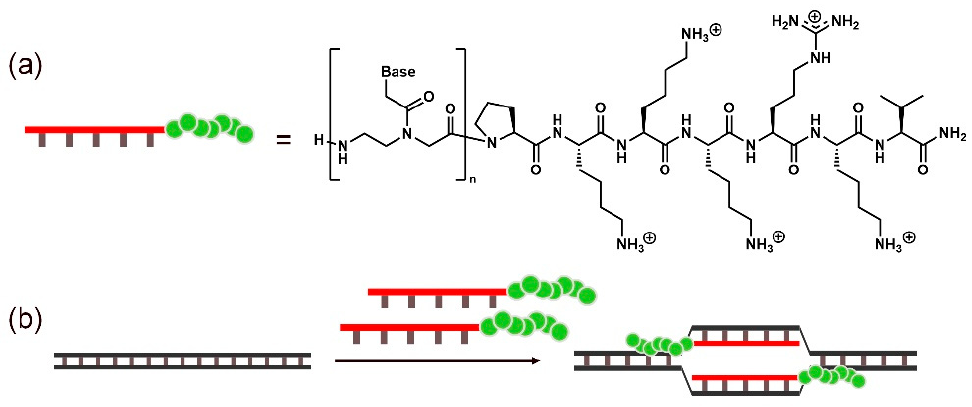
Figure 7. ( a ) Structure of NLS-PNA conjugate. The NLS peptide was directly attached to the C-terminus of pcPNAs. ( b ) Promotion of double-duplex invasion by NLS-pcPNAs.